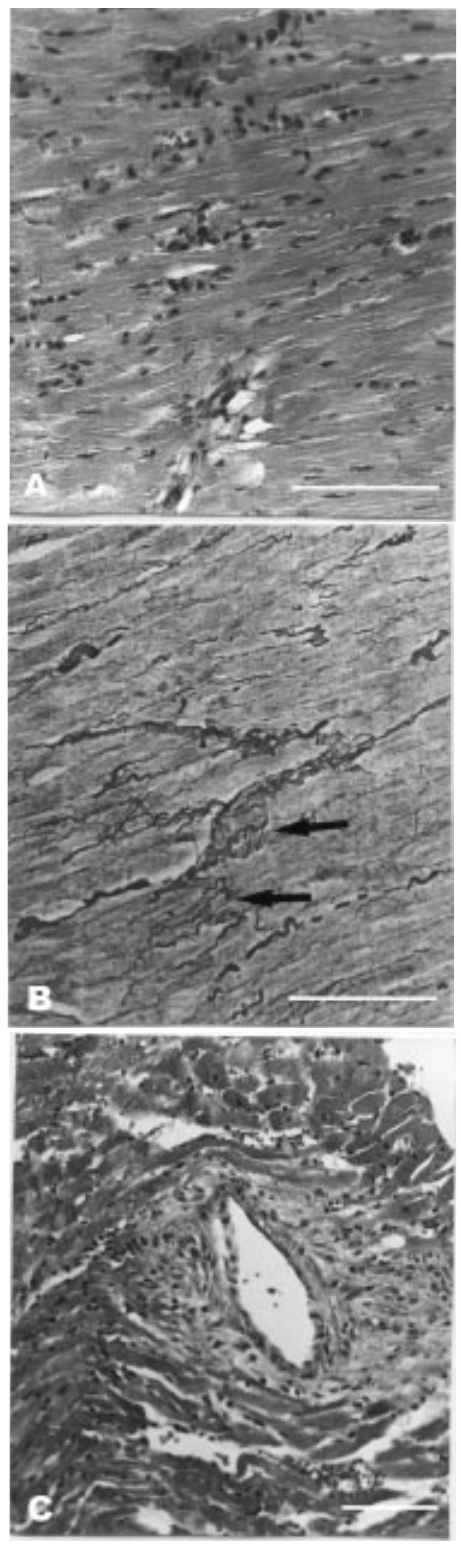
Figure 2 - Photomicrographs of myocardium from a renovascu- lar hypertensive rat sacrificed af- ter 4 weeks of left renal artery clipping. Panel A , Tissue stained with hematoxylin-eosin illustrat- ing a necrotic process and accu- mulation of inflammatory cells. Panel B , Silver staining of the same tissue from panel A. Note the collapse and disarray of the reticular framework (arrows). Panel C , Hematoxylin-eosin- stained tissue illustrating a peri- arteritis process. Note the ad- ventitial lymphomononuclear in- flammatory exudate and edema. Magnification bar: 500